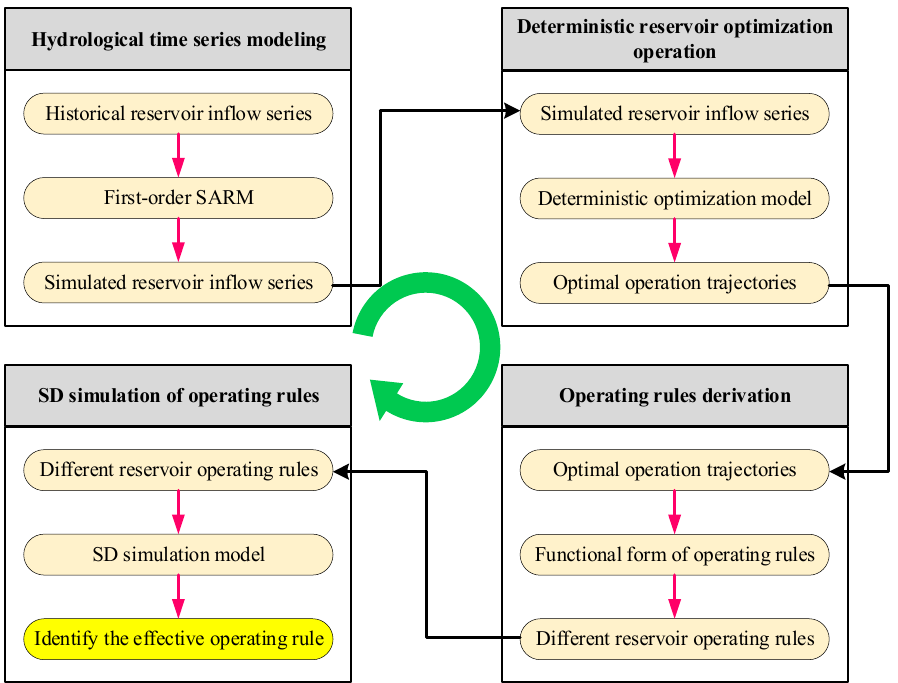
Figure 1. Schematic of the methodology.